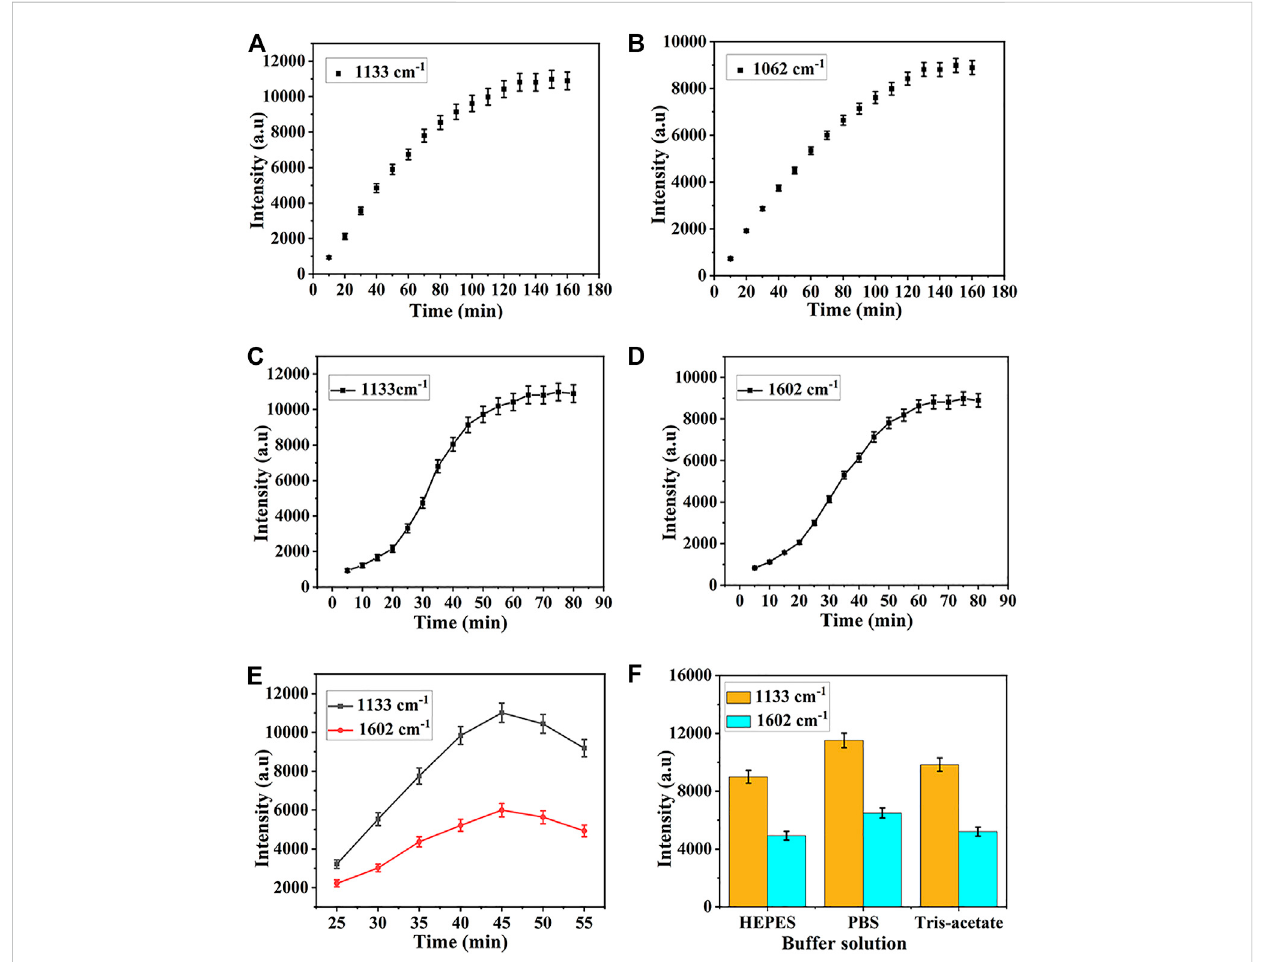
FIGURE 5 Optimization of (A) assembly time for HP1, (B) assembly time for HP2 (C) hybridization time for HP1, (D) hybridization time for HP2, (E) temperature, and (F) category of buffer